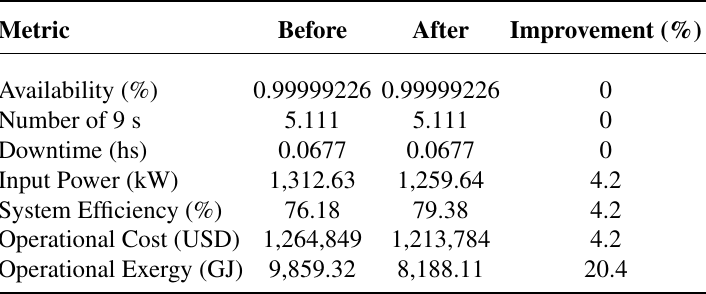
Table 1. Summary results before and after PLDA